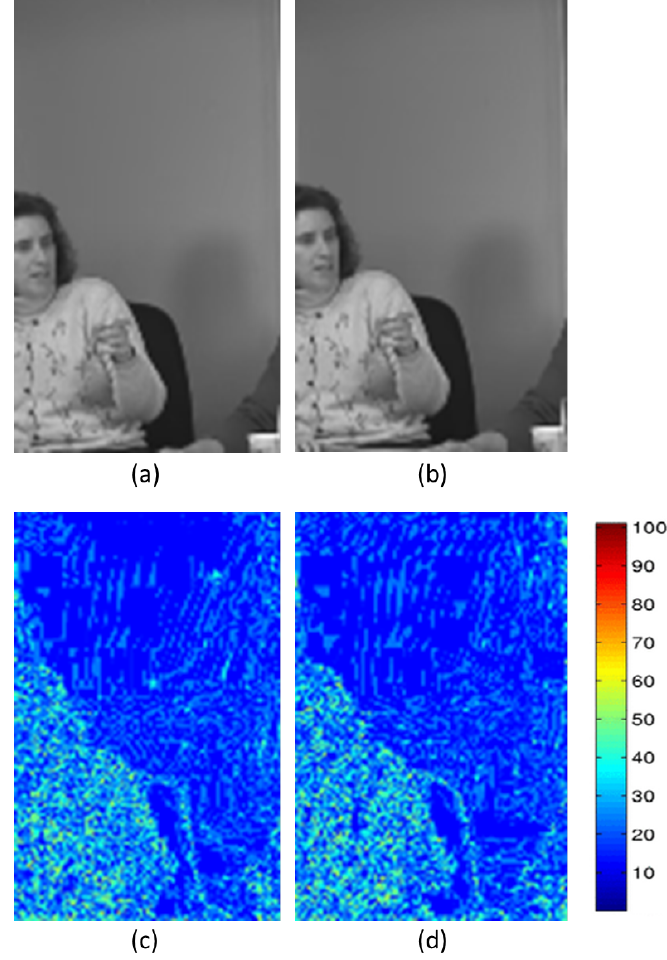
Figure 7. PSNR comparison. ( a ): Picture encoded using R k = 0.5. ( b ): Picture encoded using R k = 0.3. ( c ): PSNR comparison of R k = 0.5 picture with the original image. ( d ): PSNR comparison of R k = 0.3 picture with the original image.